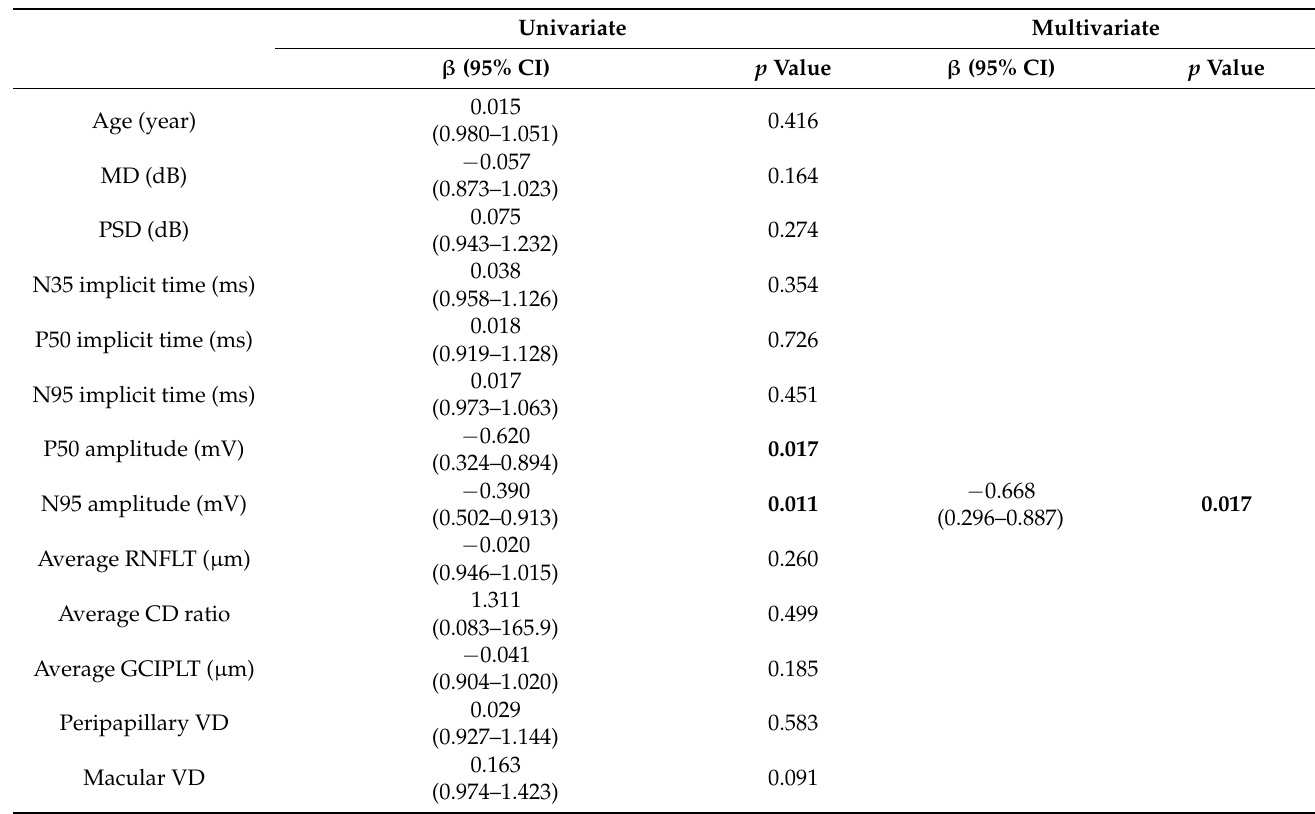
Table 3. Logistic Regression Analysis of Factors associated with the Presence of Circumparapapillary Choroidal Microvasculature